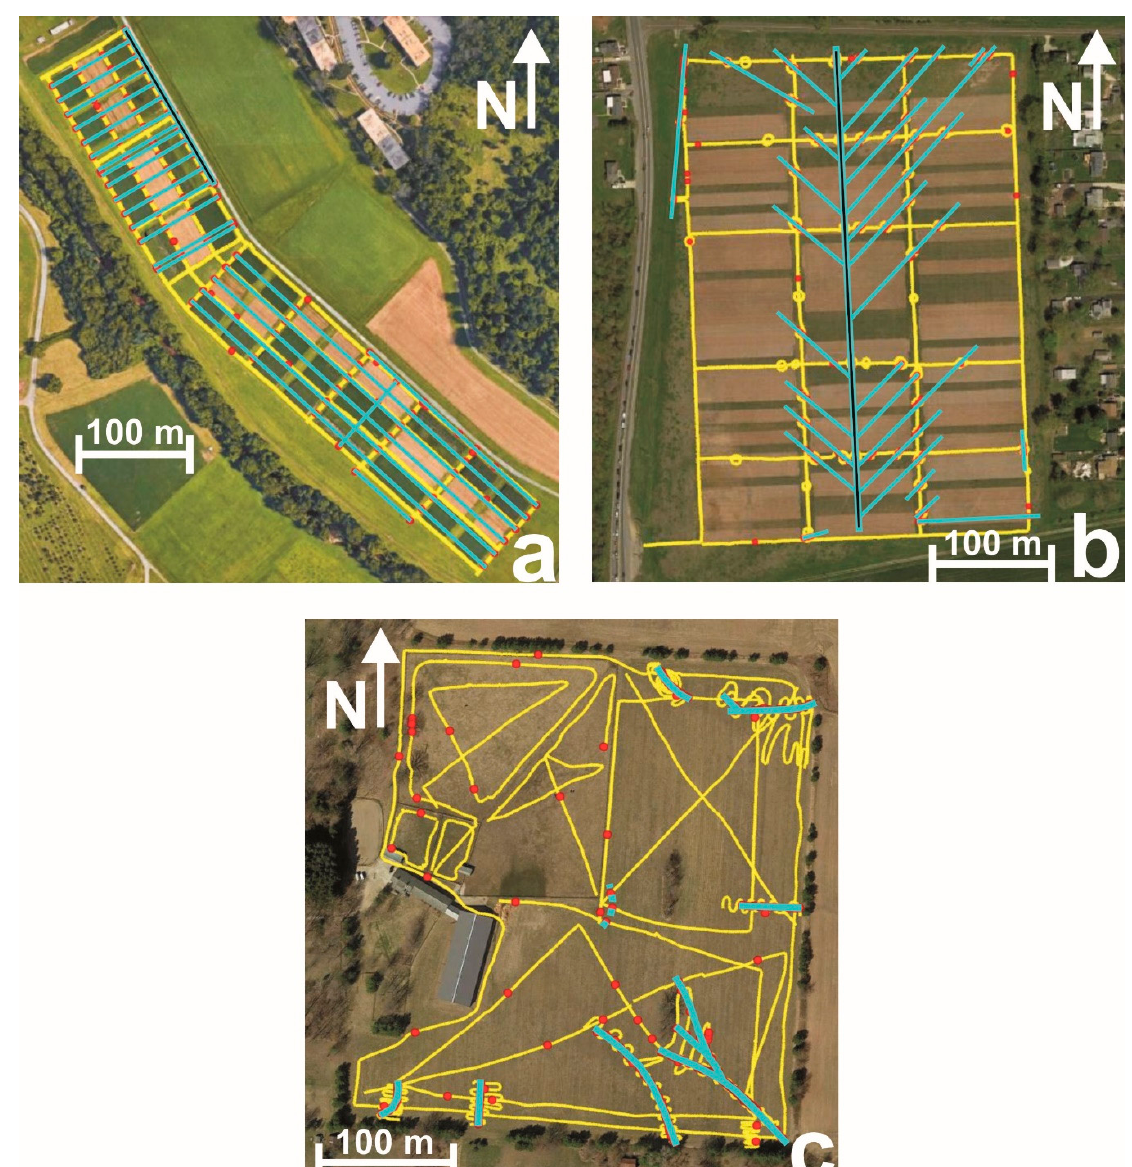
Figure 9. Interpreted drain line patterns (blue lines) overlaid on GPR measurement transects (yellow lines) and potential drainage pipe locations (red dots): ( a ) Site 1; ( b ) Site 2; and ( c ) Site 3. A thin black line within a thicker blue line indicates a main collector pipe.